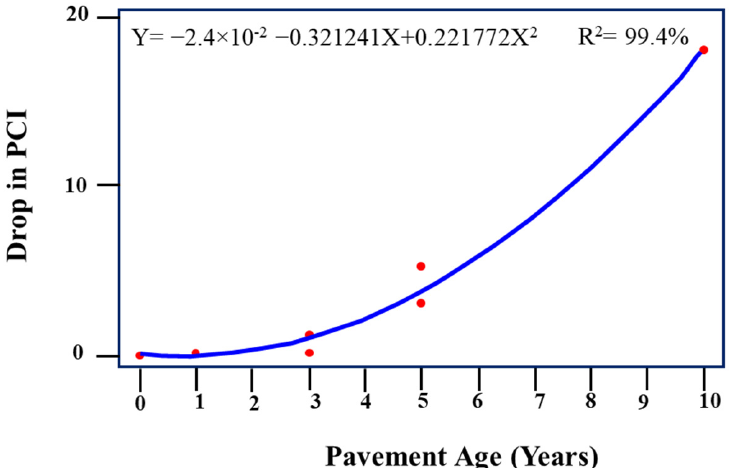
Figure 12. Effect of reconstruction on the deterioration of PCI for high traffic. As indicated in the above figures, the effect of routine maintenance and reconstruc ‐ tion is greater in low traffic than in high traffic, whereas the effect of overlay is greater in high traffic than in low traffic. 5.7. Pavement Maintenance Performance Expert System The expert system developed using eight regression performance models is easy to operate and self ‐ explanatory. The steps to run the program are listed below: 1.